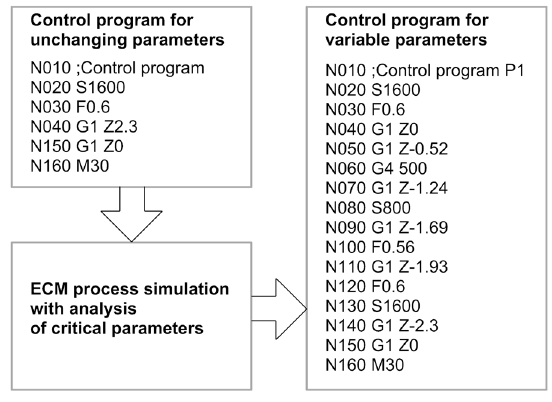
Figure 6. Adaptive control diagram.